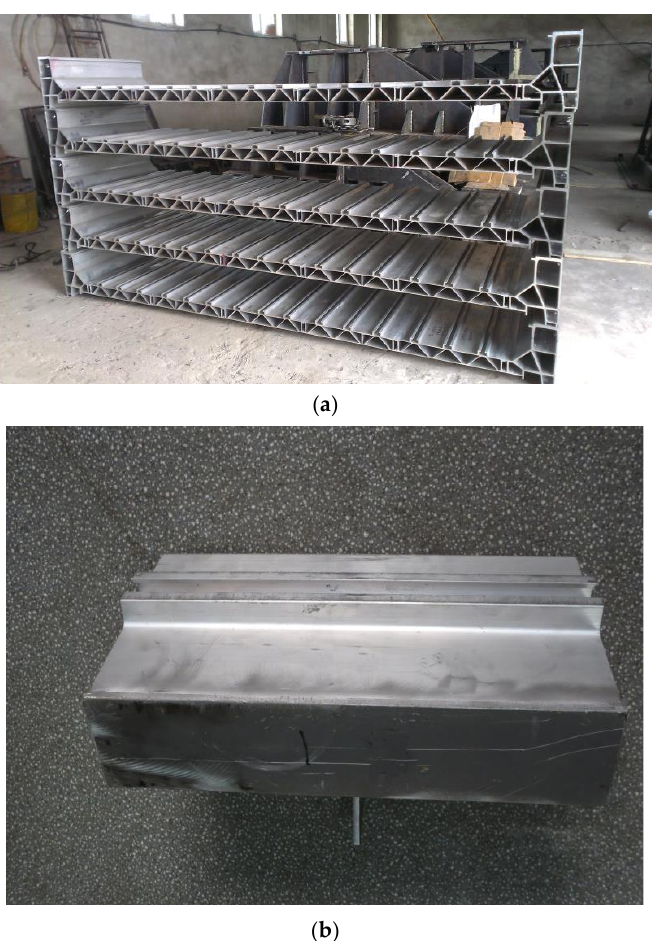
Table 2. Chemical composition of the structure material.